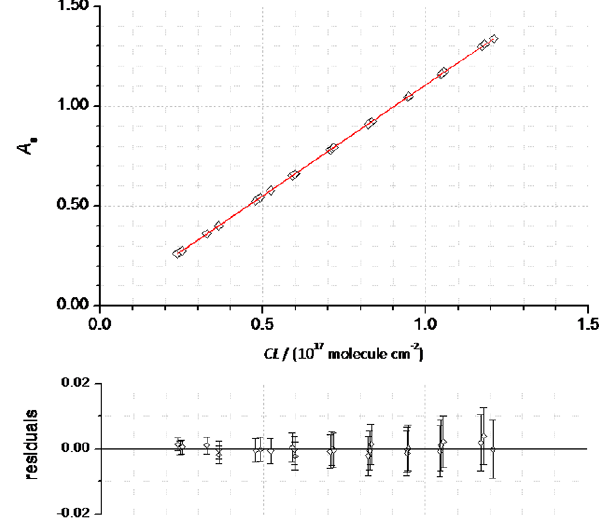
Figure 7. Example of the linear regression of measurements results recorded at the laser wavelength